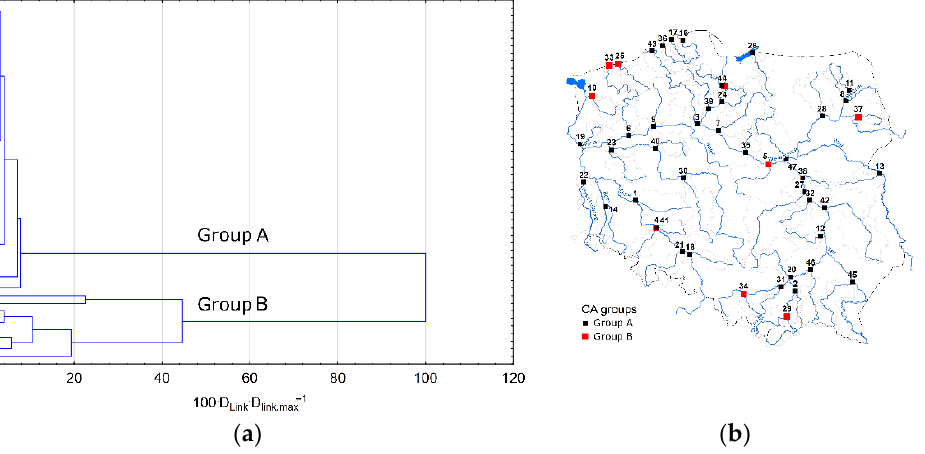
Figure 7. Results of cluster analysis ( a ) and their spatial projection against Poland ( b ). The num- bers of sampling points are listed in the Appendix A. of sampling points are listed in the Appendix A.